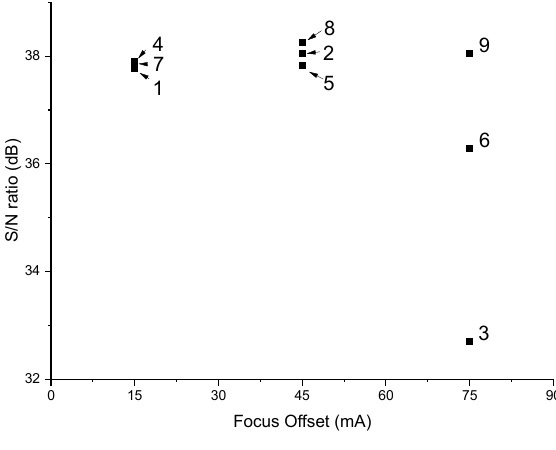
Figure 11. Focus offset effect.